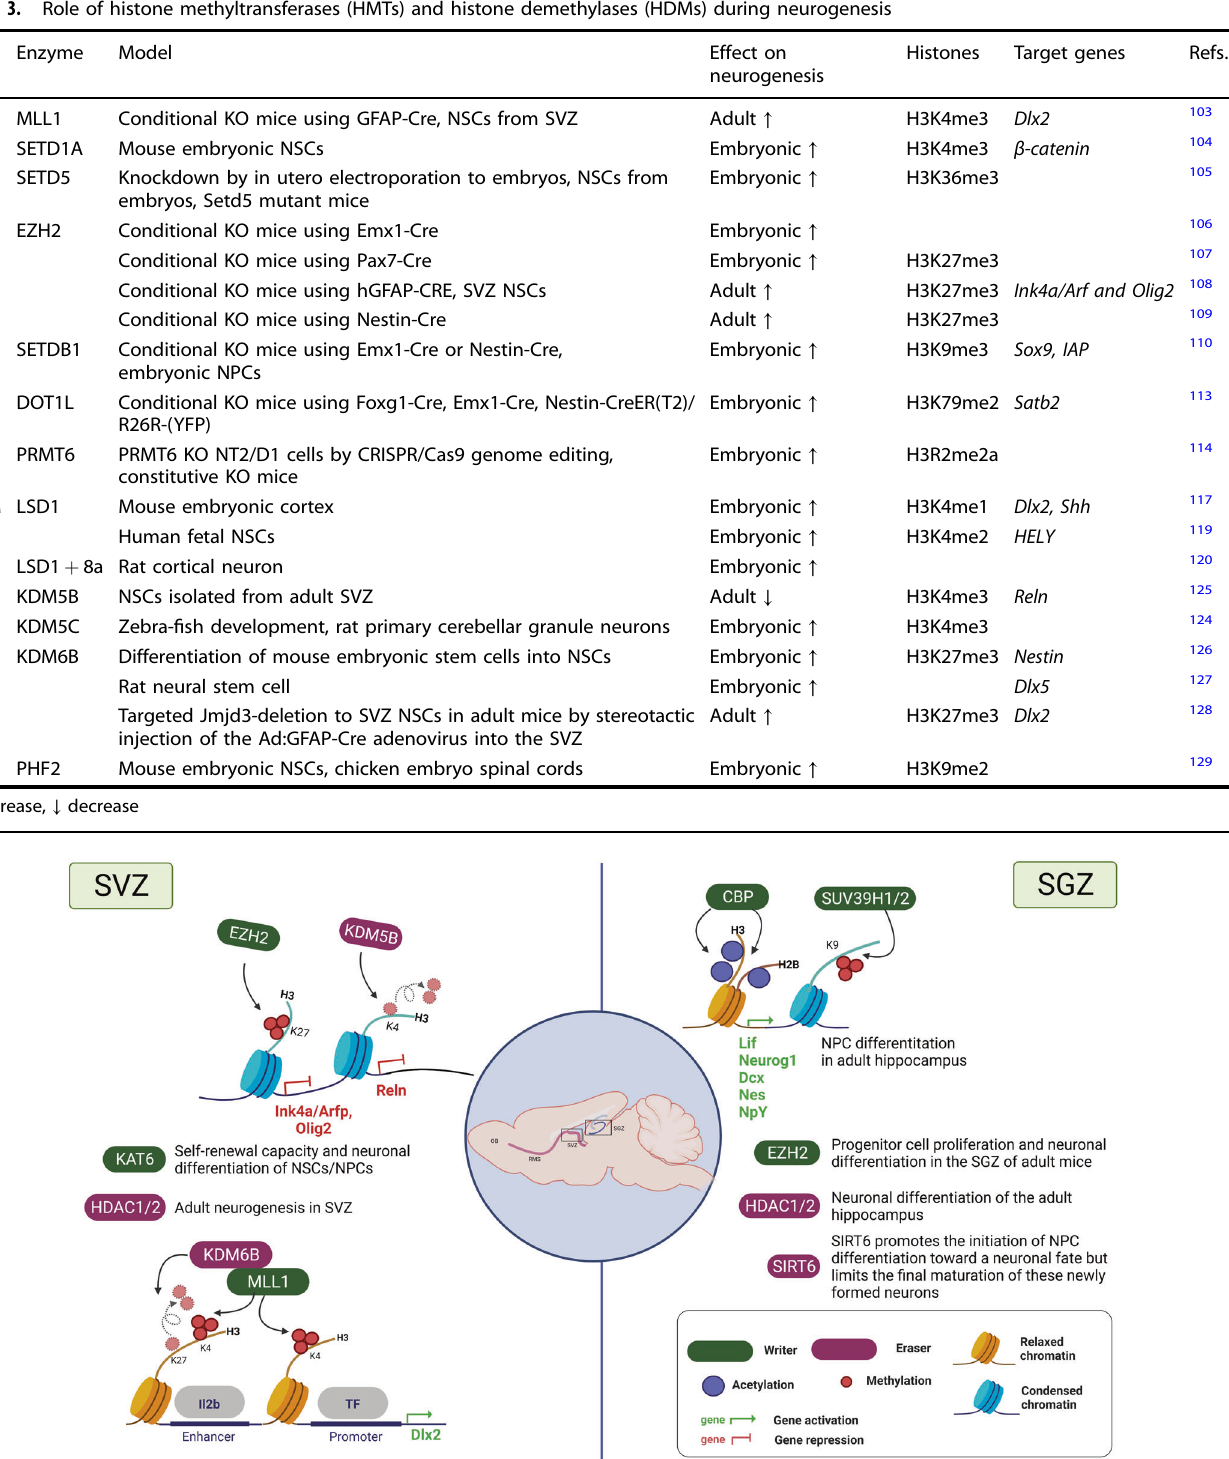
Table 3. Role of histone methyltransferases (HMTs) and histone demethylases (HDMs) during neurogenesis Enzyme Model Effect on